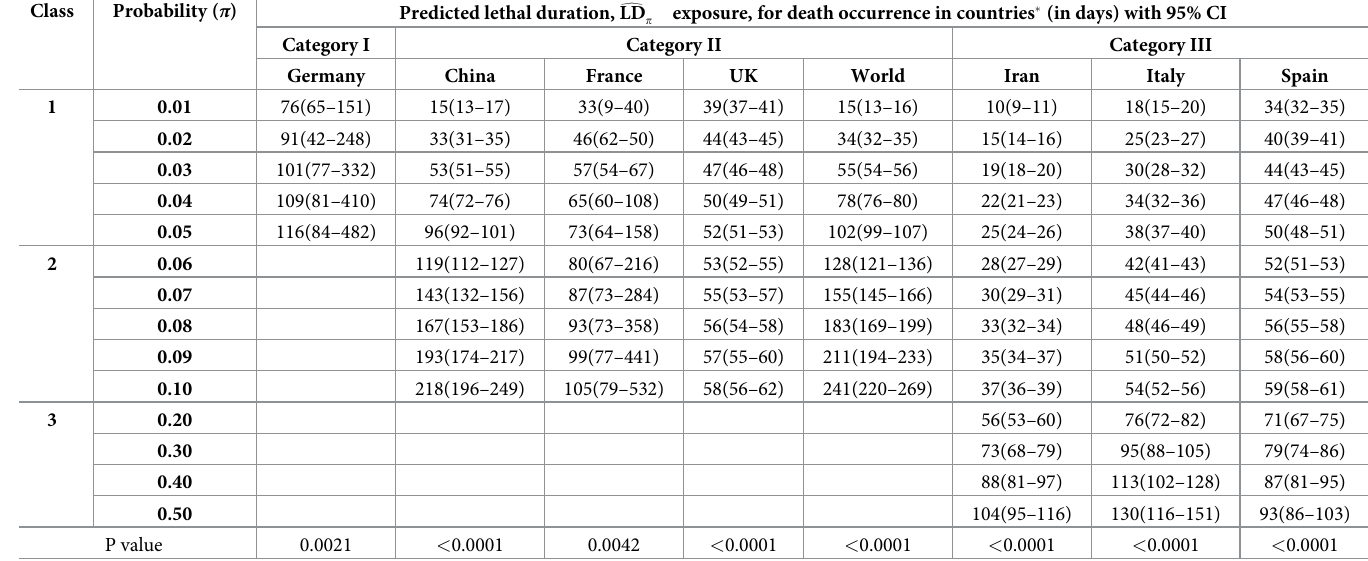
Table 2. Predicted lethal duration, LD ^ ð t Þ (in days), in different countries due to COVID-19 for the given probability of death ( π p